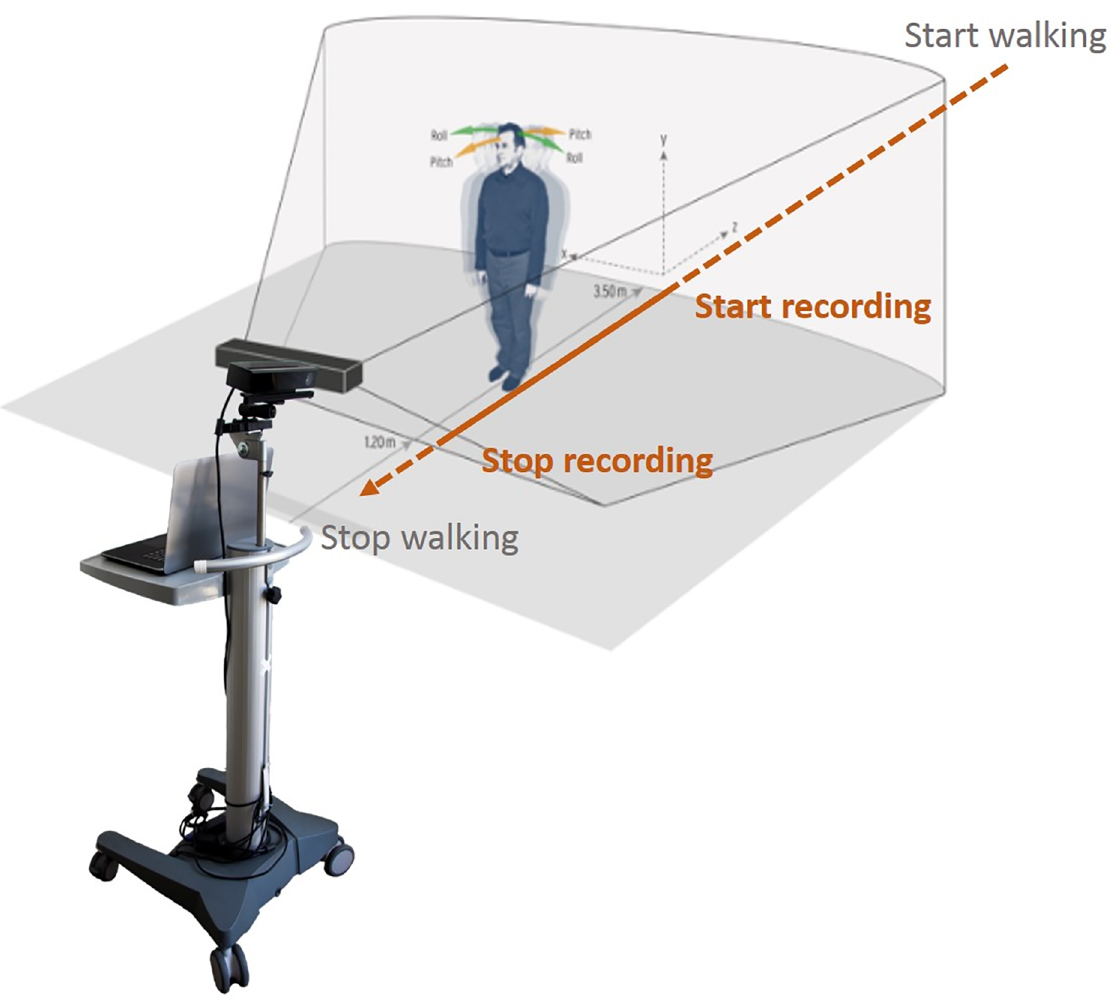
Fig 1. Test set-up.